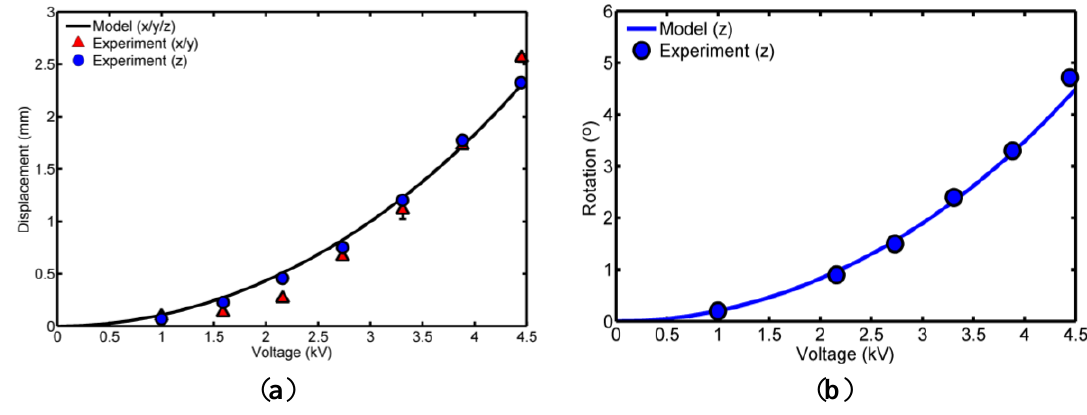
Figure 6. ( a ) Lateral displacement in x , y and z -axes; and ( b ) rotational output about z -axis against